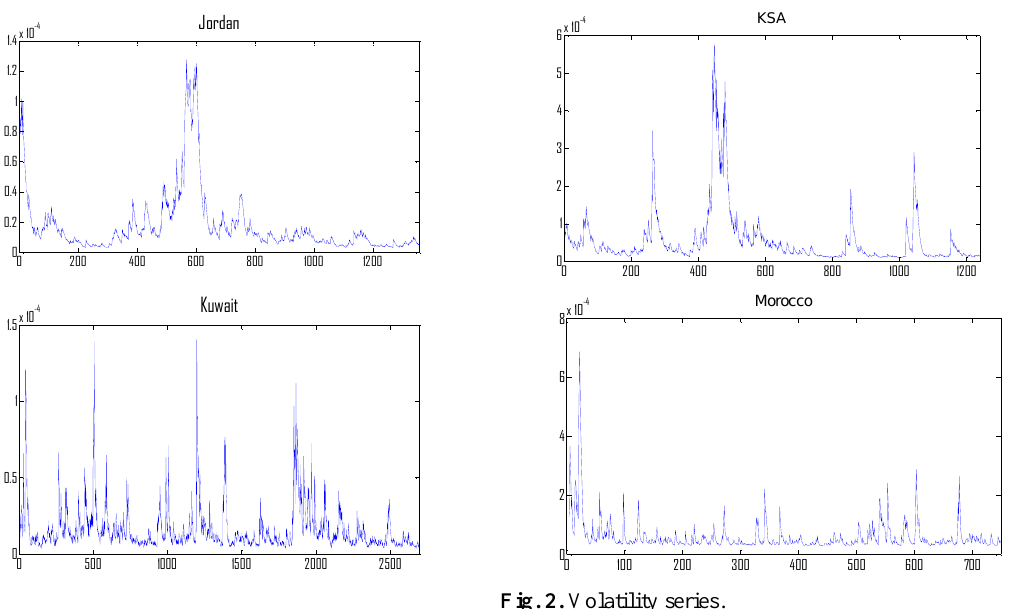
Fig. 2. Volatility